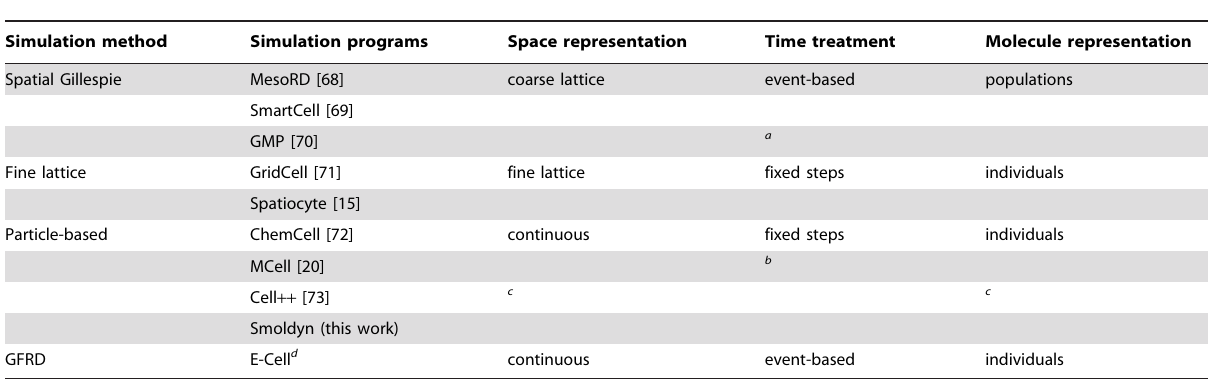
Table 1. Biochemical simulation methods that account for spatial and stochastic